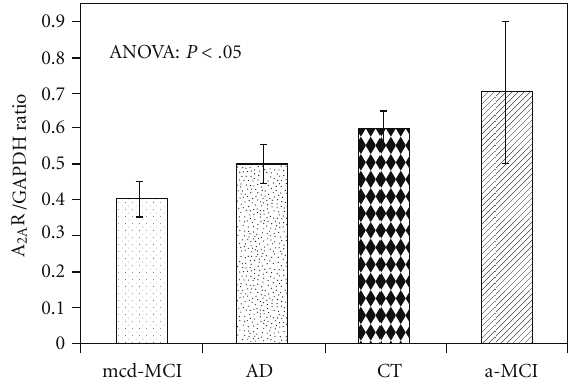
Figure 3: A 2A R densities (mean values ± standard error) in PBMCs from 27AD, 10 a-MCI, 20mcd-MCI, and 20 control (CT) subjects expressed as A 2A R/GAPDH ratio. Bonferroni post hoc: a-MCI versus controls and mcd-MCI patients ( P < .